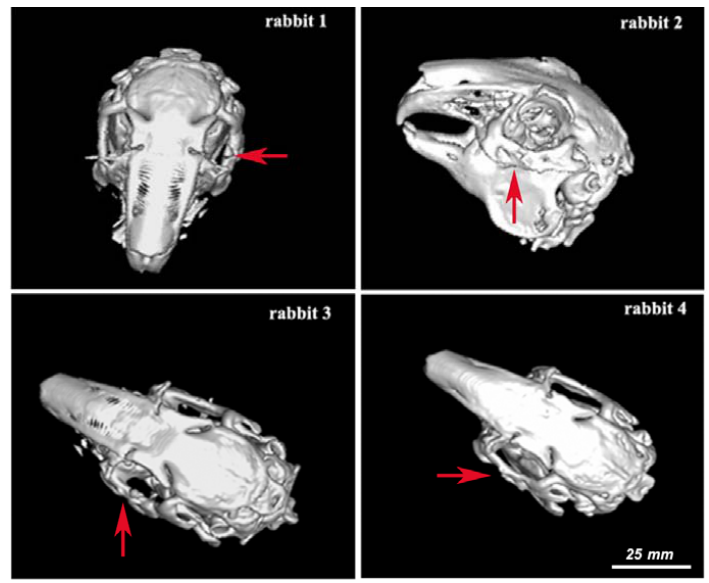
Figure 6. 3D CT osseous reconstruction images at one month postoperative for rabbits 1–4. Scale was estimated based on corresponding 2 ‐ D image.